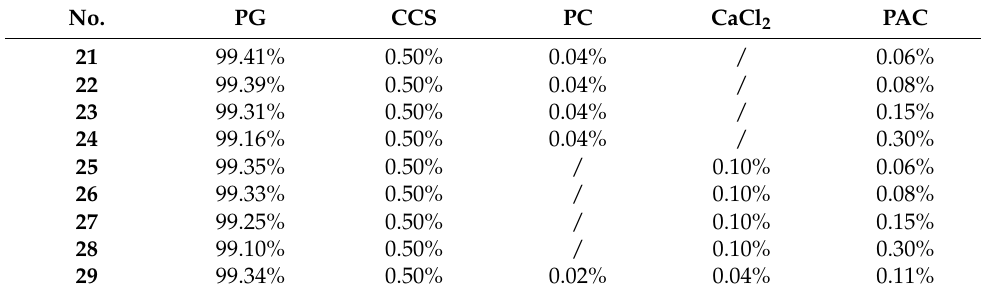
Table 2. Different ratios of CCS and